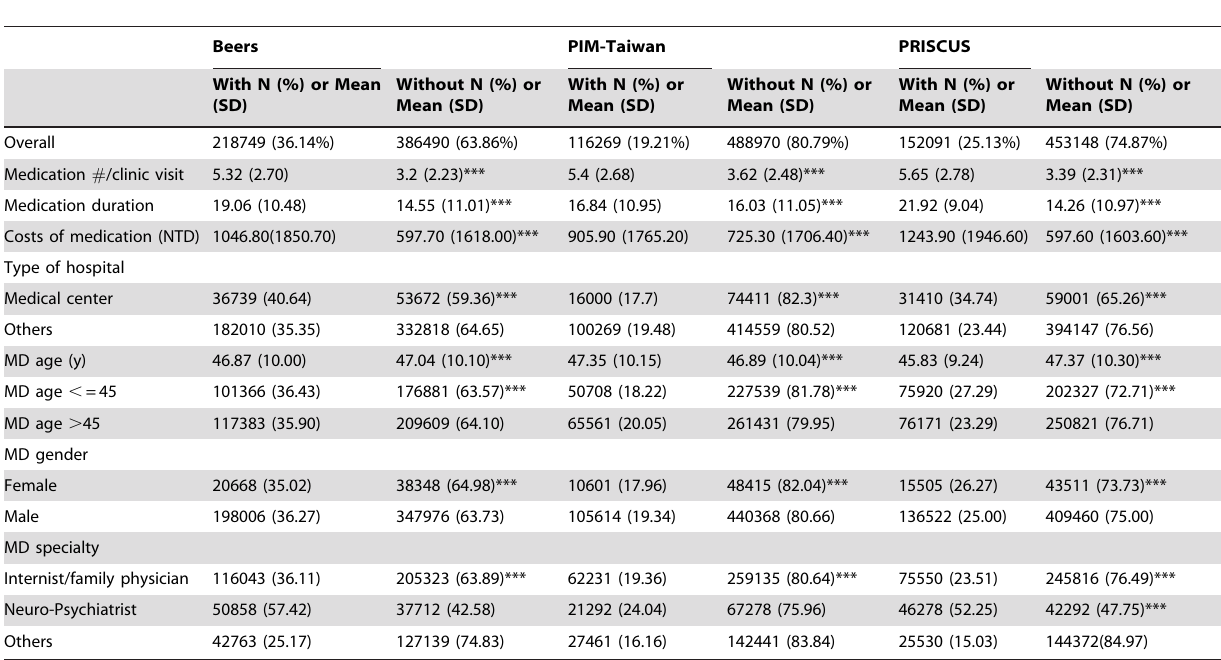
Table 5. Clinic visit-level bivariate analysis (N= 605239) according to the three sets of potentially inappropriate medication criteria.